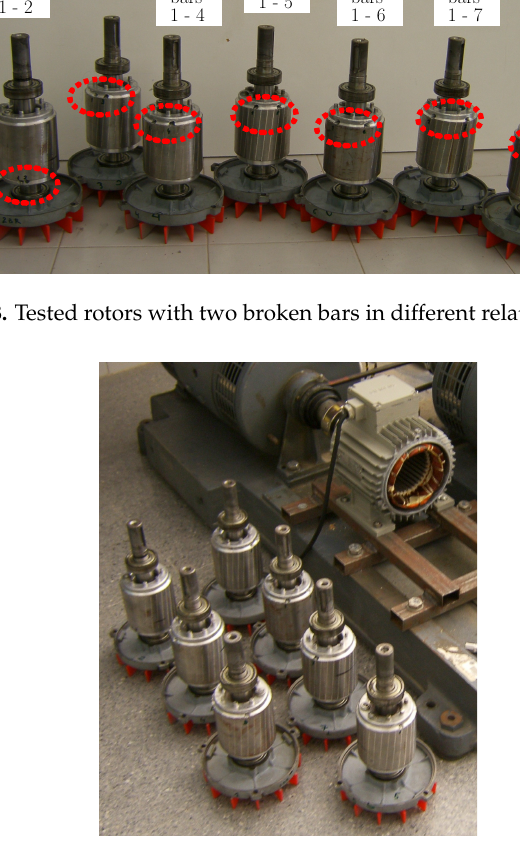
Figure 9. Tested rotors with two broken bars in different relative positions, with the stator used for performing all the experimental tests.